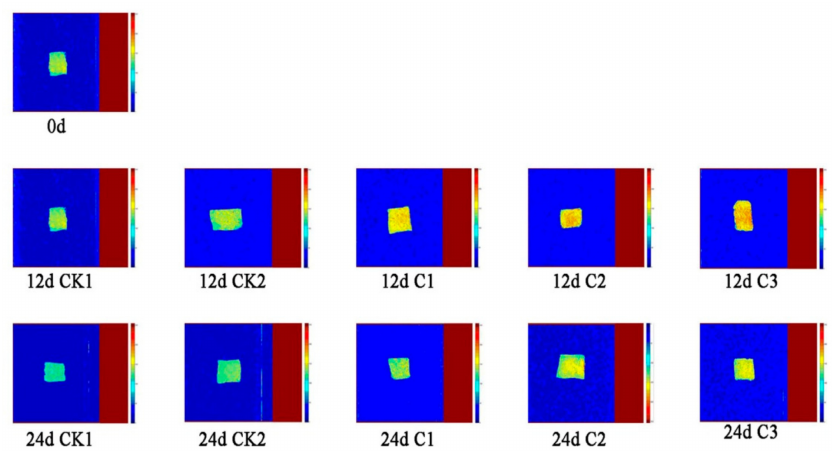
Figure 3. Results of magnetic resonance imaging (MRI) of samples under different treatments during refrigerated storage (CK1: distilled water + air packing; CK2: edible coating + air packing; C1: edible